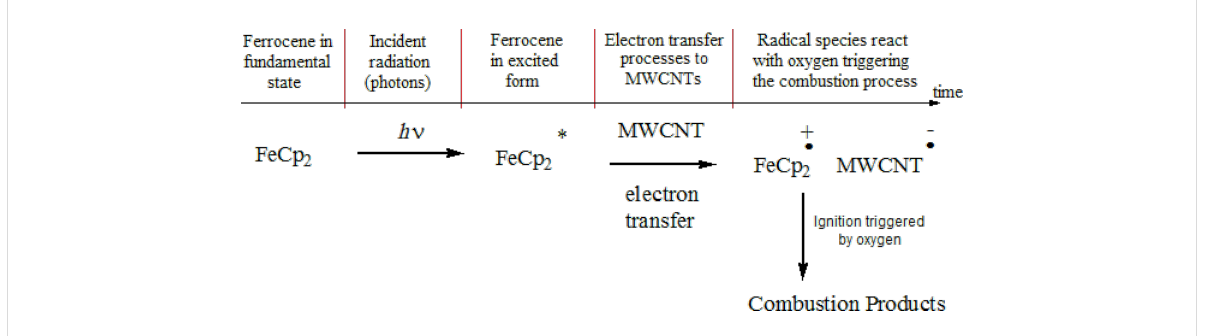
Figure 17: Chemical reactions relative to photo-induced electron and energy transfer in MWNTs–FeCp 2 nanocomposites occurring during the photo- induced ignition process.